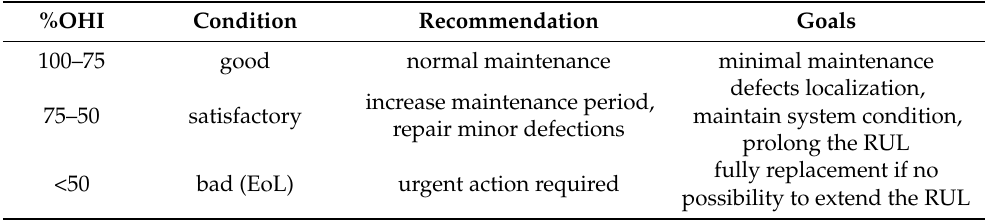
Table 9. Maintenance strategy recommendation for underground cable